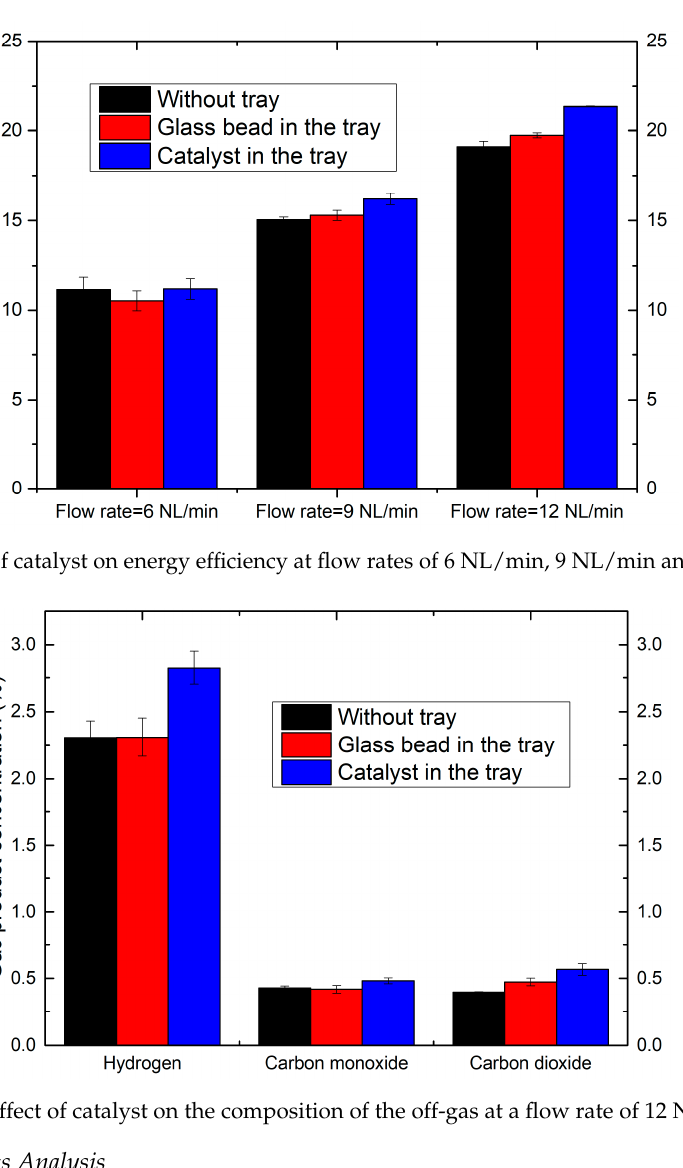
Figure 18. Effect of catalyst on destruction efficiency at flow rates of ( a ) 6 NL/min, ( b ) 9 NL/min and ( c ) 12 NL/min.